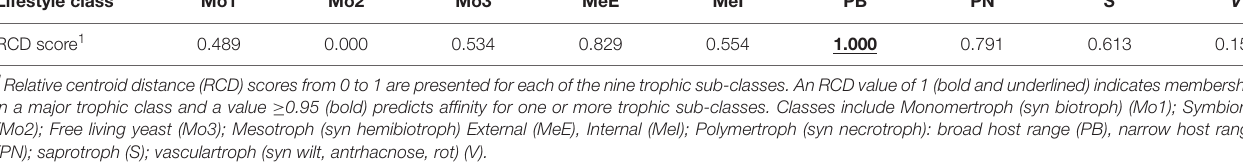
Frontiers in Plant Science |